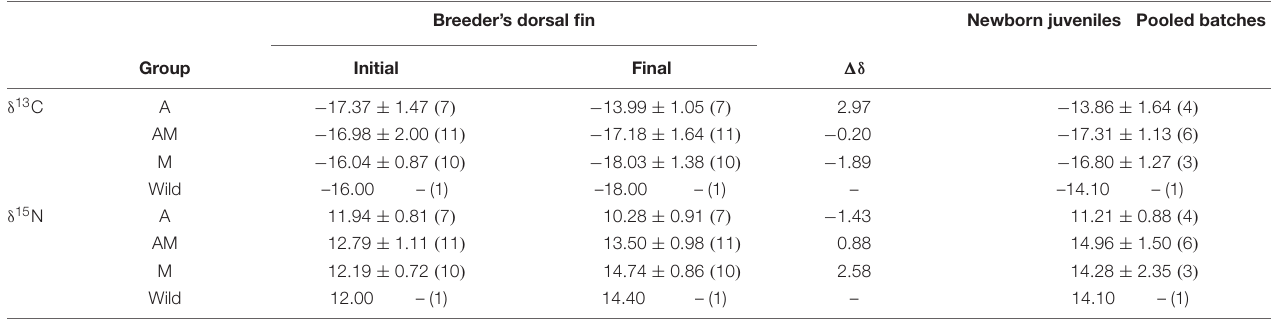
TABLE 3 | Isotope profiles ( δ 13 C ) in dorsal fins (start and end of the experimental breeding period) of Hippocampus guttulatus breeders fed on diets A ( Artemia ), AM ( Artemia + Mysidacea) and M (Mysidacea), and in newborn juveniles. Breeder’s dorsal